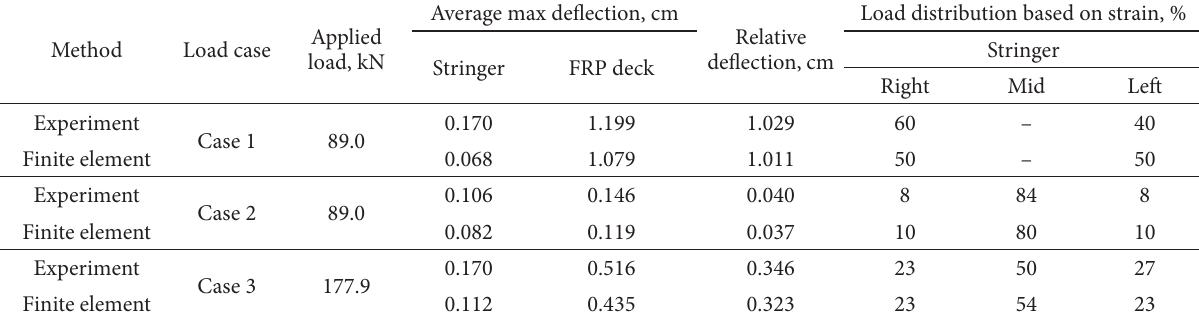
Fig. 4. Finite element models simulated by laboratory experiments Table 3. Comparison between finite element and experimental results for FRP deck